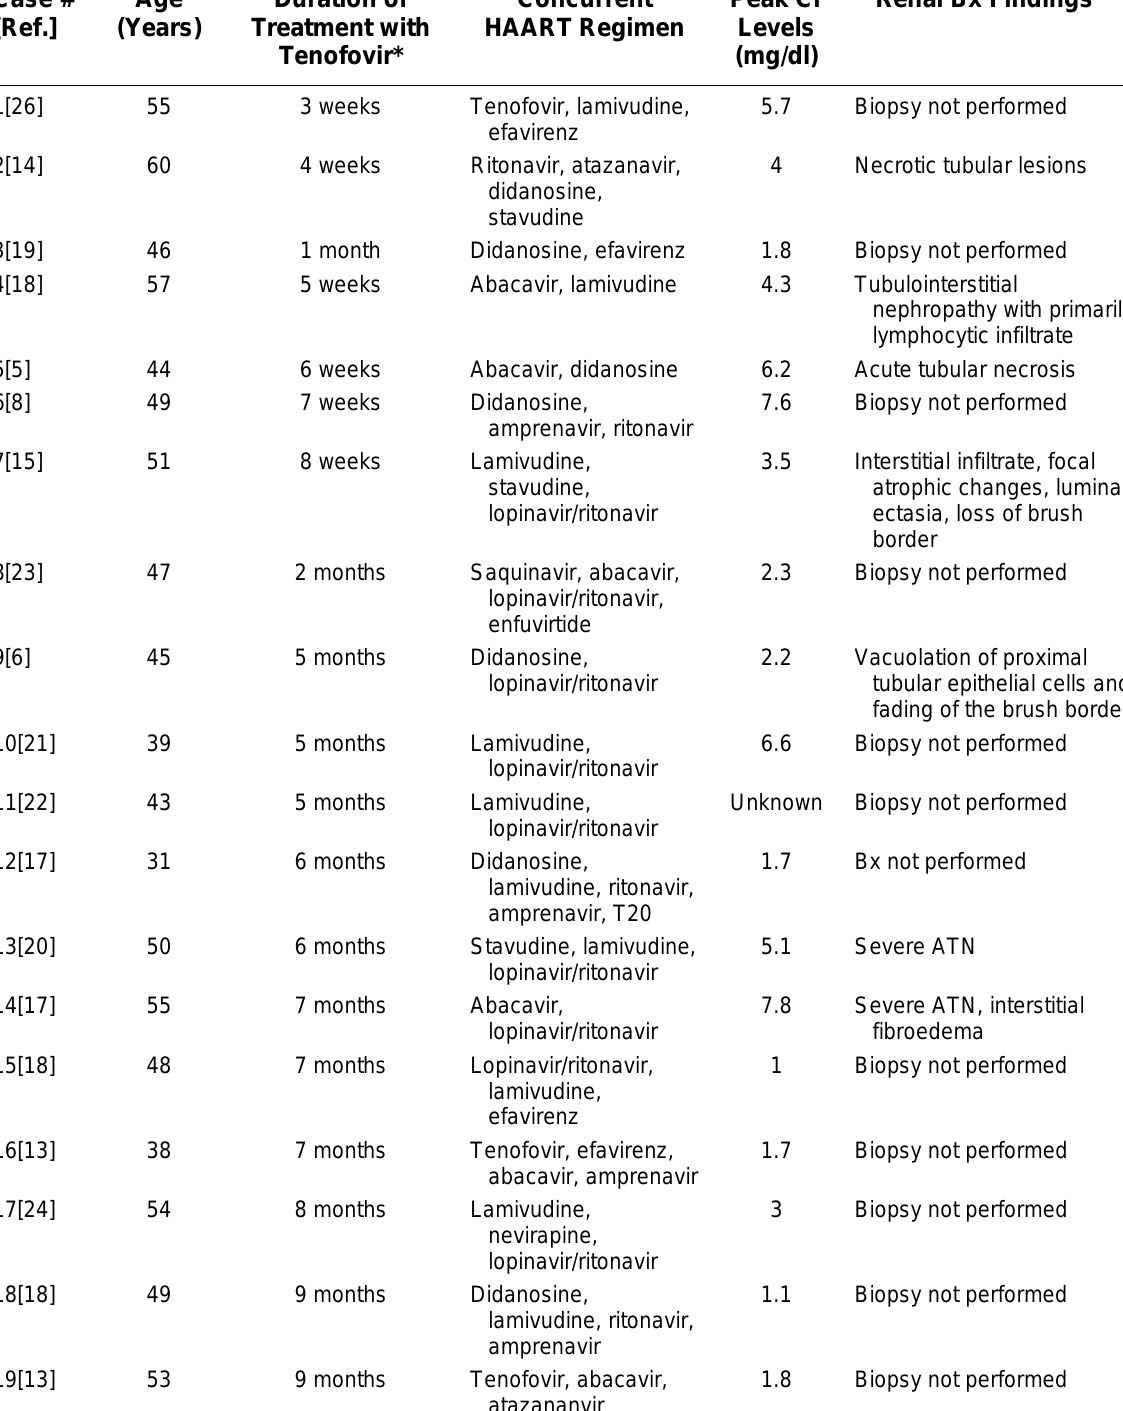
Cases of Tenofovir-Associated Renal Failure Reported in the